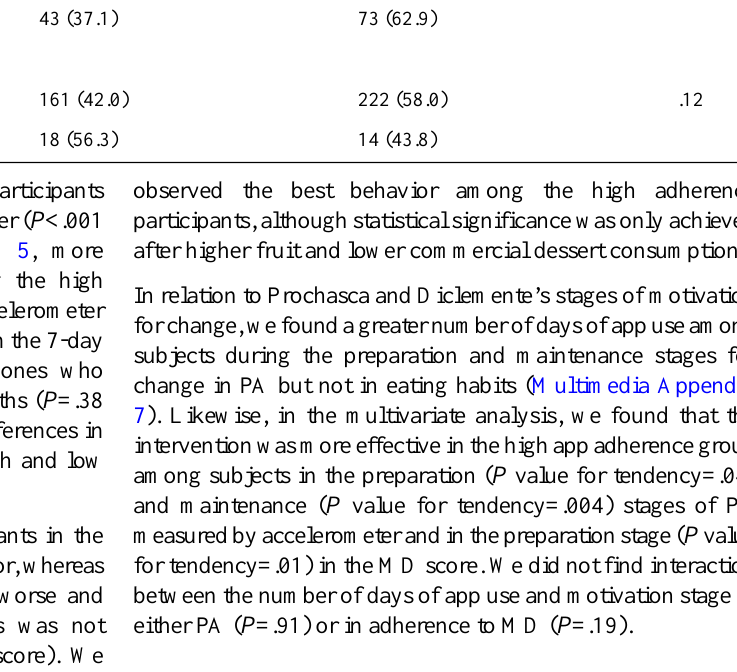
Figure 3. Adherence to the smartphone app (number of days with a record in the app). High adherence (>60 days)=57%; Low adherence ( ≤ 60